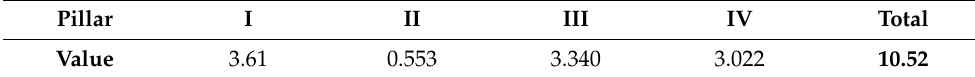
Table 3. All Pillars values for